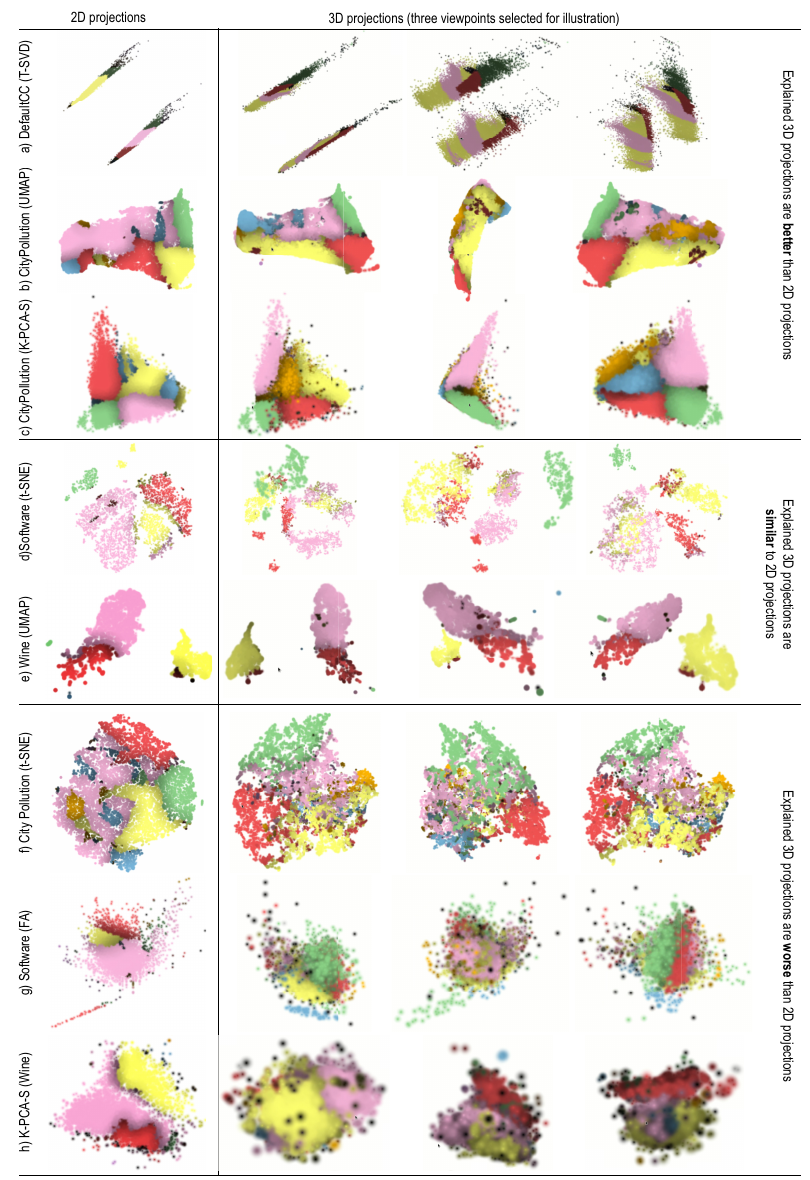
Figure 6. Selected examples from user evaluation showing how variance-explained 3D projections can be better than, similar to, or worse than, 2D projections (Section